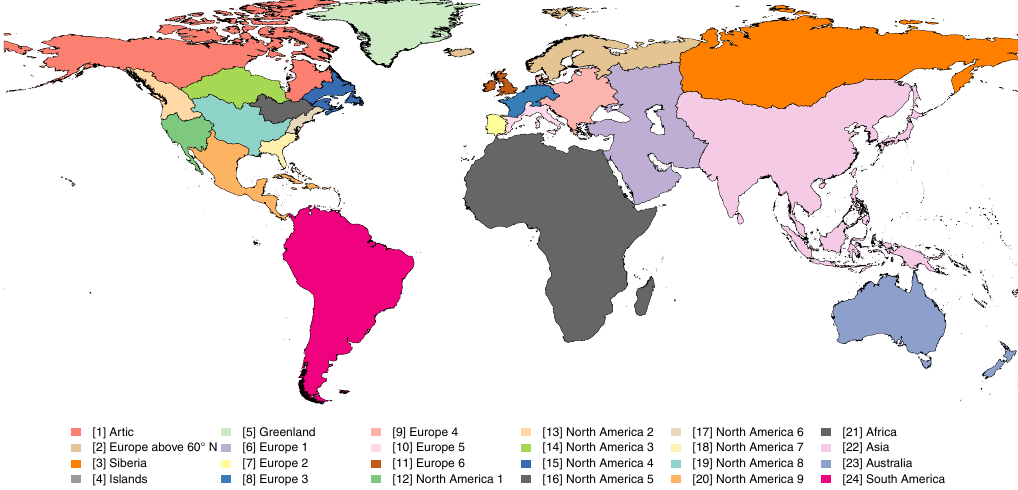
Figure 3. GSIM regions for catchment delineation and metadata extraction